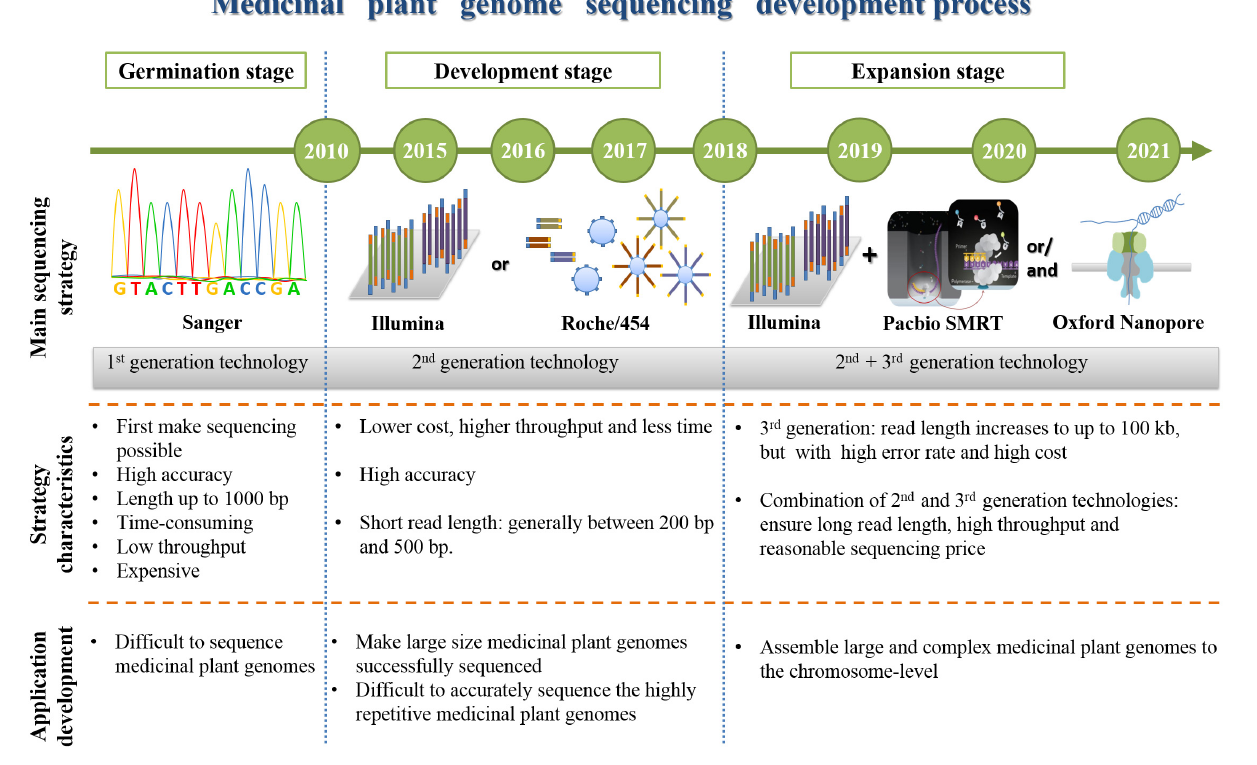
FIGURE 4 | The development process of medicinal plant genome